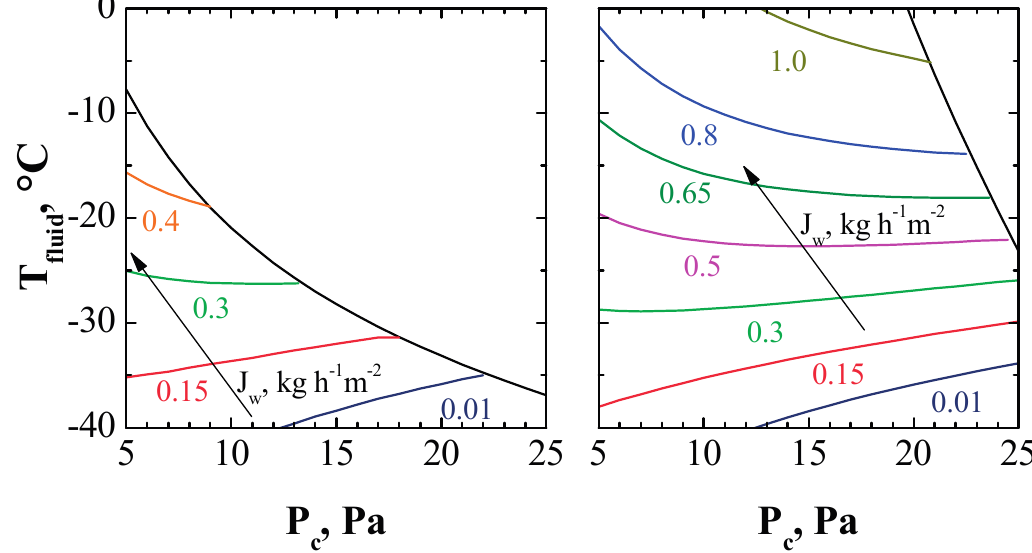
Figure 9. Values of the sublimation flux (colored lines) as a function of the operating conditions, in case the product has to be maintained below the glass transition temperature, or in case micro-collapse is allowed. Black line corresponds to the maximum allowed fluid